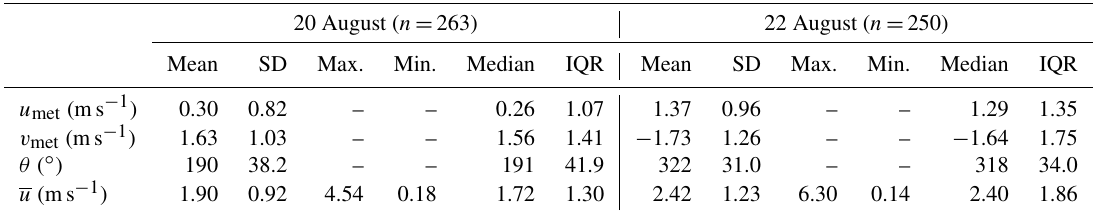
Table 4. Statistics of the mean flow measured by the car on 20 and 22 August. The averaging period is 10s; therefore, the statistics are calculated from a set of n non-overlapping intervals. Shown are the wind components in a meteorological coordinate system ( u met , v met ), the mean wind direction calculated from u met and v met , as well as the mean wind speed after rotation into a streamwise coordinate system. Note that u includes a component due to the vertical velocity, and hence it may exceed the horizontal wind speed calculated as u h = The standard deviation of the wind direction is calculated using the Yamartino algorithm (Turner,